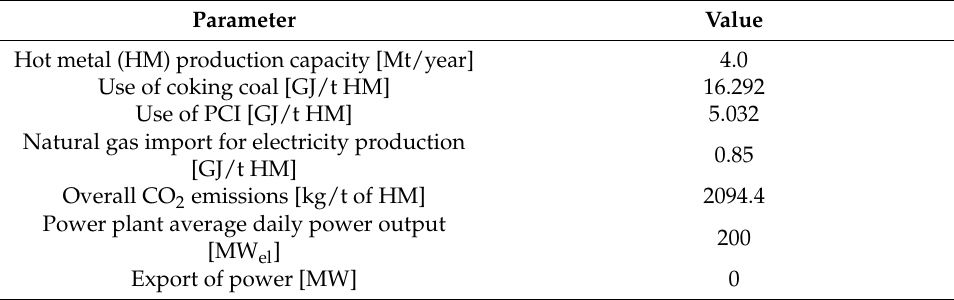
Table 1. Key data for the baseline steel mill [12].